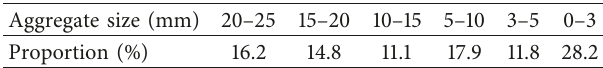
Table 3: Composition of macadam for cement-stabilized macadam.